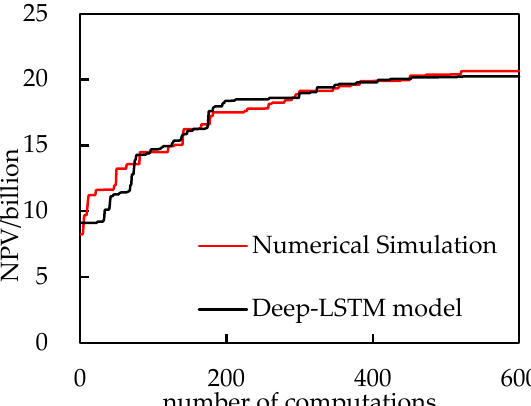
Figure 9. Comparing the process of optimizing NPV using different methods.